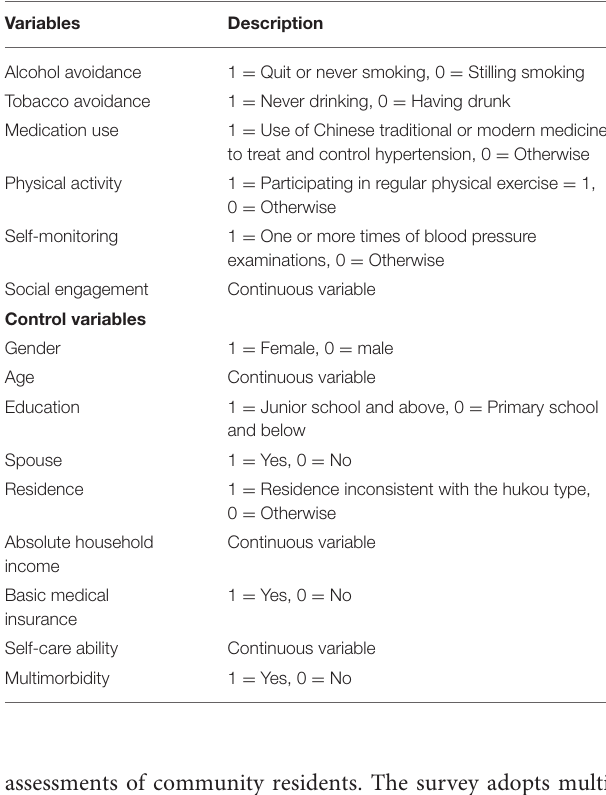
TABLE 1 | Variable